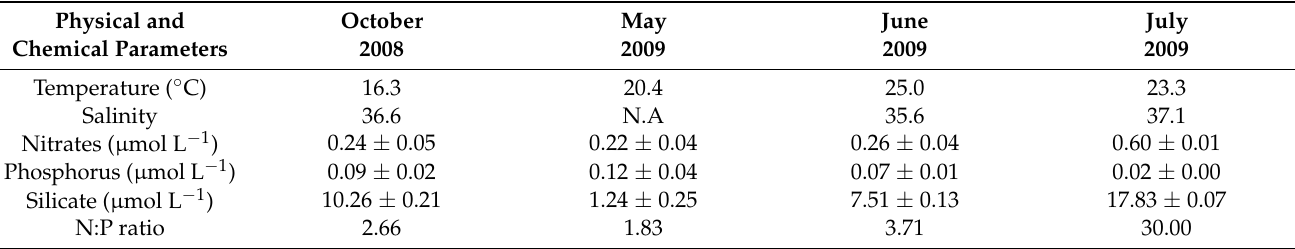
Table 1. Initial temperatures, salinity and nitrate levels, and phosphorus and silicate concentrations ( ± SD) for each of the four dilution experiments carried out in October 2008, May 2009, June 2009, and July 2009. N.A indicates that the data are not